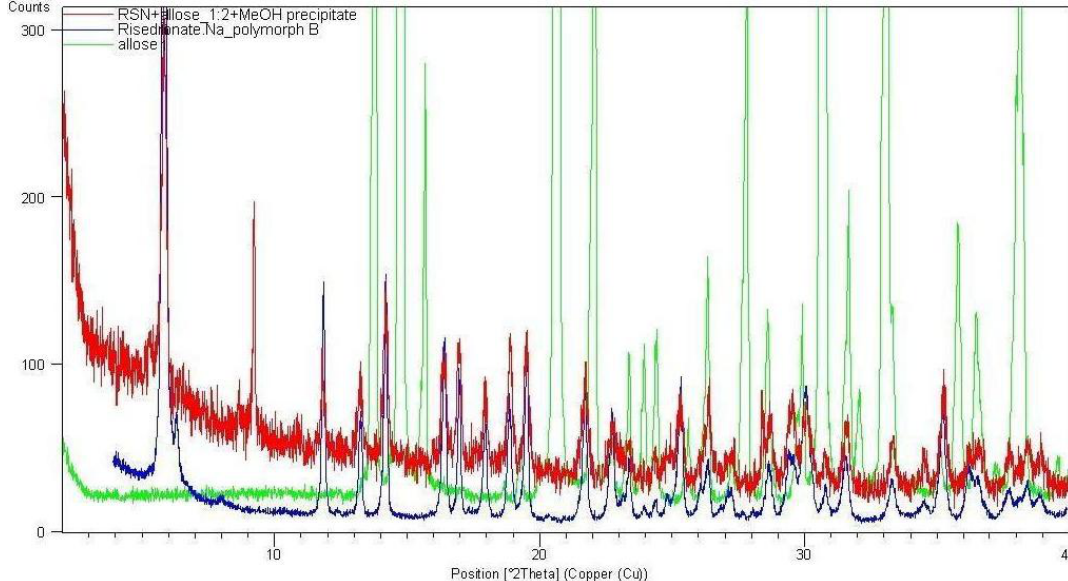
Figure 9. XRPD patterns of allose, sample RSN+allose in ratio 1:2 and risedronate mono-sodium salt form